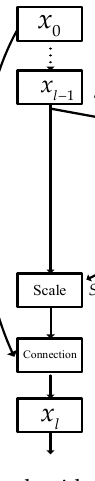
Figure 4. Dense network with spectral-wise attention mechanism.